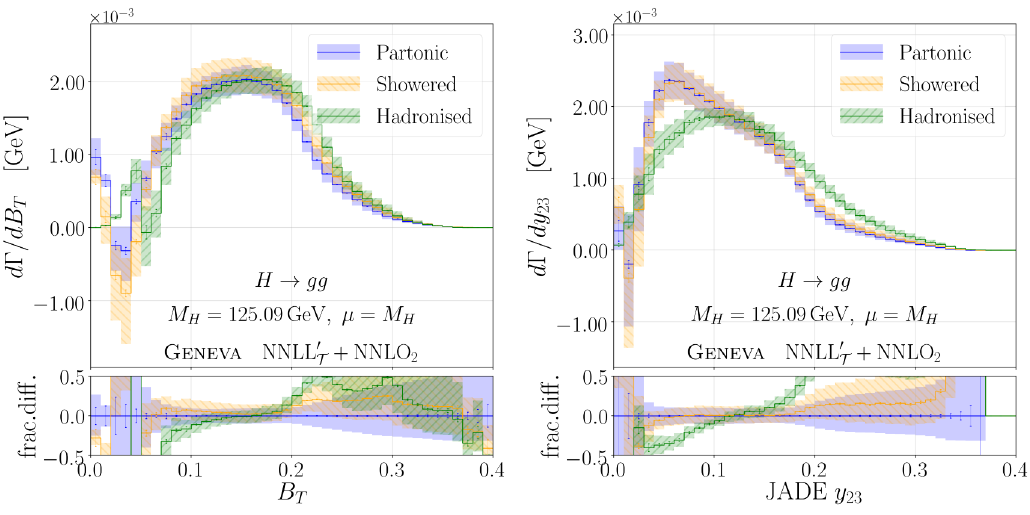
Figure 10. Jet broadening and the JADE two-to-three differential jet rate at the partonic, showered and hadronised levels for H ! gg